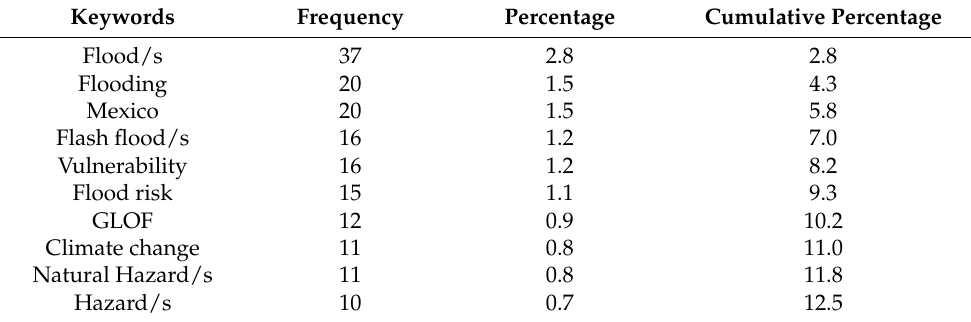
Table 4. Ranking of the top-10 keywords in LAC’s flood-related articles published in the period 2000–2020. GLOF: Glacial Lake Outburst